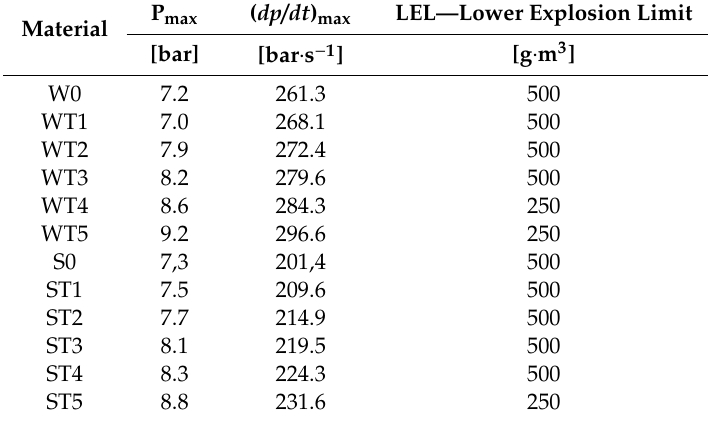
Table 2. The results of analyses assessing dust from raw and torrefied willow biomass and wheat straw. P max ( dp / dt ) max LEL—Lower Explosion Limit Material [bar] [bar · s − 1 ] [g · m 3 ]